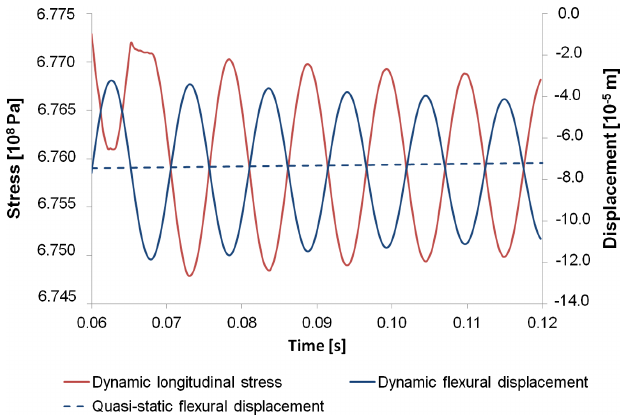
FIG. 23. Dynamic flexural displacement ( x -direction) and dynamic longitudinal stress ( z -direction) detected on the colli- mator jaw assembly at z ¼ 0 . 42786 m between t ¼ 0 . 06 s and t ¼ 0 . 12 s after the particle beam impact. It can be observed that oscillations settle at a main frequency of around 95 Hz, which is approximately equivalent to the first period of flexural oscillation of the jaw